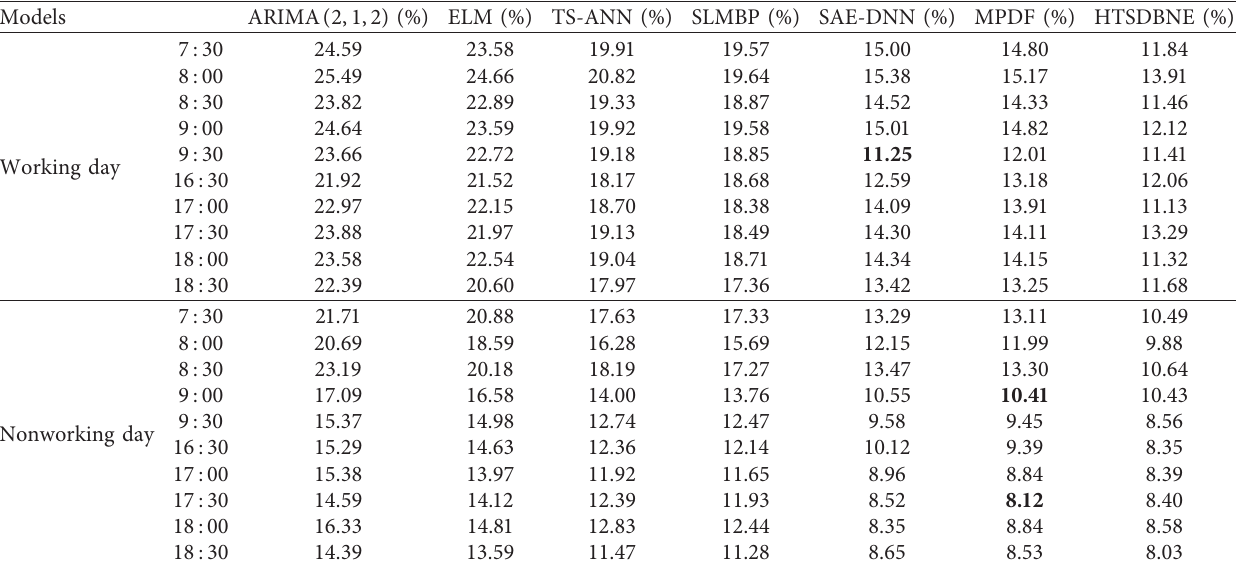
Table 7: Comparison between HTSDBNE and other models (MAPE) (station 7 of line 28).